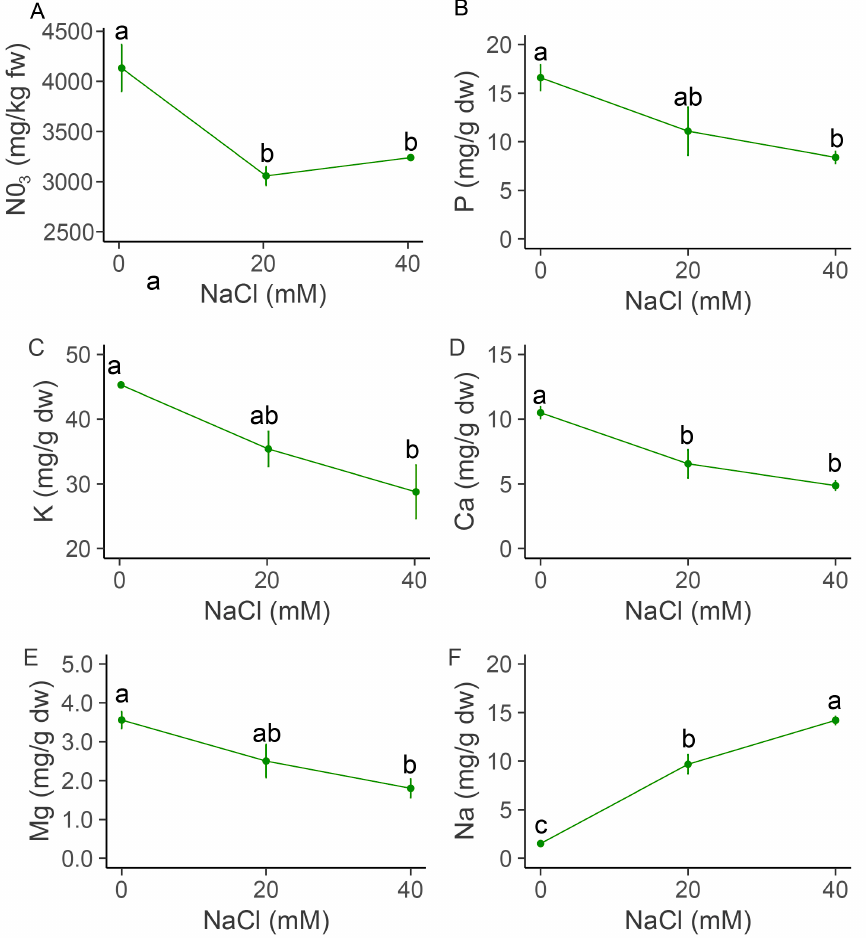
Figure 3. Effects of the NaCl in the nutrient solution on the elemental composition of the basil leaves: ( A ) nitrate; ( B ) P; ( C ) K; ( D ) Ca; ( E ) Mg; ( F ) Na. Data are mean ± standard error of the mean. Different letters indicate significantly different means according to the Tukey HSD test ( p < 0.05).